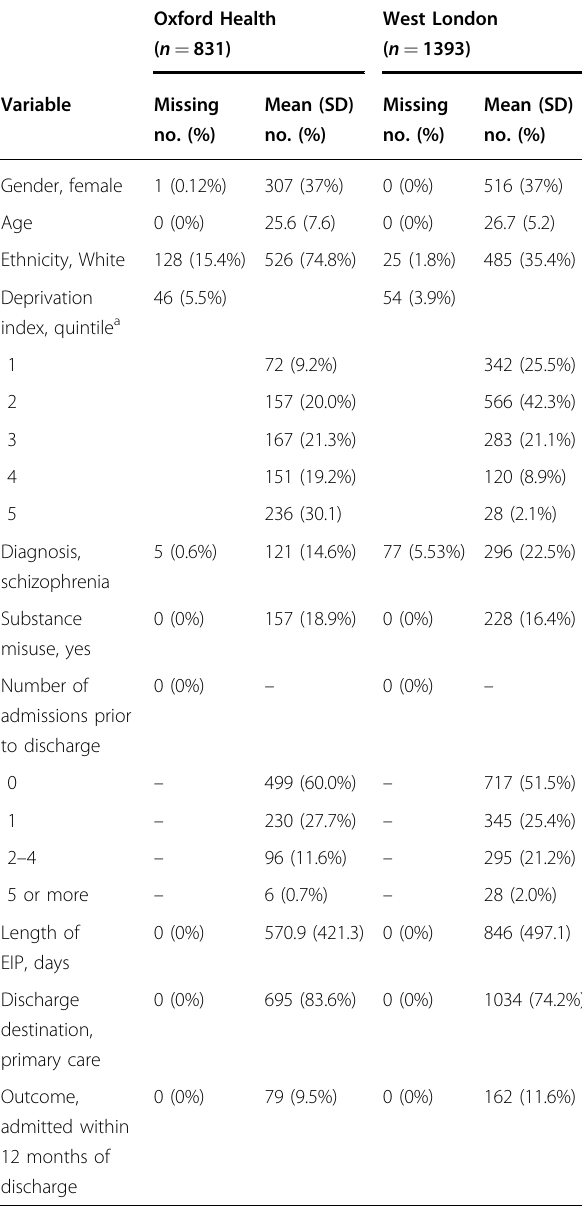
Table 1 Demographics, clinical service use and outcome comparison between Oxford Health NHS Foundation Trust and West London NHS